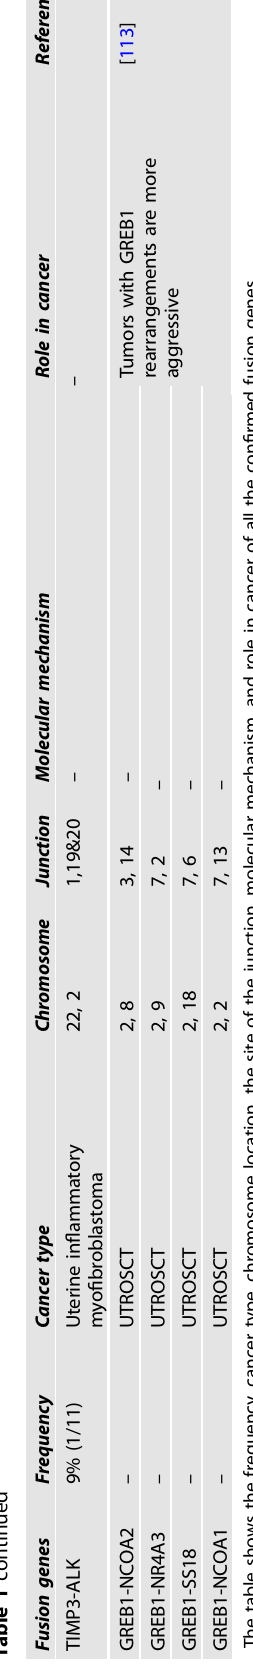
activity, and the silencing or activation of an enhancer is usually mediated by certain transcriptional activation or repressor factors. For example, the transcriptional activator STAT5 activates the transcription of target genes (such as MYC and BCL2) by binding to their enhancer regions and co-exists with enhancer markers such as BRD4, P300, and H3K27ac. The NUP214-ABL fusion is considered to be a key factor in inducing acute T-cell leukemia (Fig. 3f). The fused protein can activate STAT5 through phosphorylation, and activated STAT5 can increase the transcriptional activity of its target genes signi fi cantly [47, 48]. In AML, the RUNXI-ETO fusion protein is considered to be an oncogenic transcription factor (Fig. 3f). The RUNX1-ETO fusion protein replaces the wild-type RUNX1 protein and binds to the open chromatin region upstream of the CCND2 transcription start site (TSS), resulting in the abnormal activation of CCND2, which drives the occurrence of AML [49].